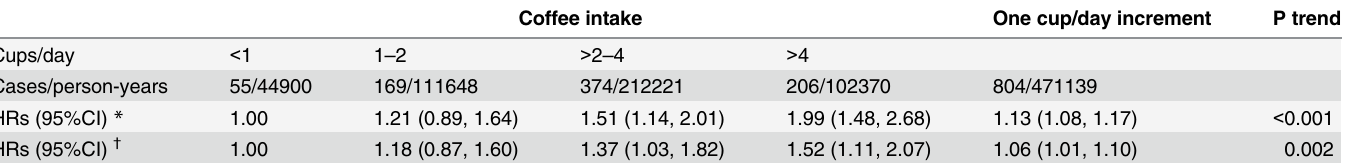
Table 2. Hazard ratios (HRs) for developing CHD in relation to daily coffee intake. Coffee intake One cup/day increment P trend